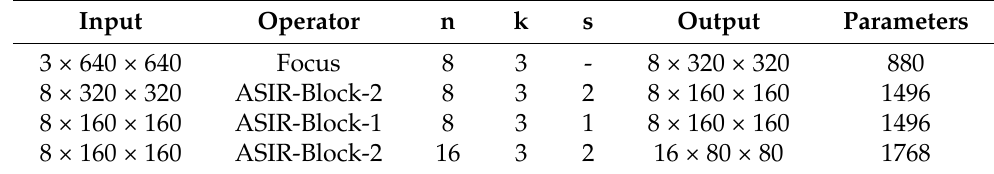
Table 2. Specifications of the proposed